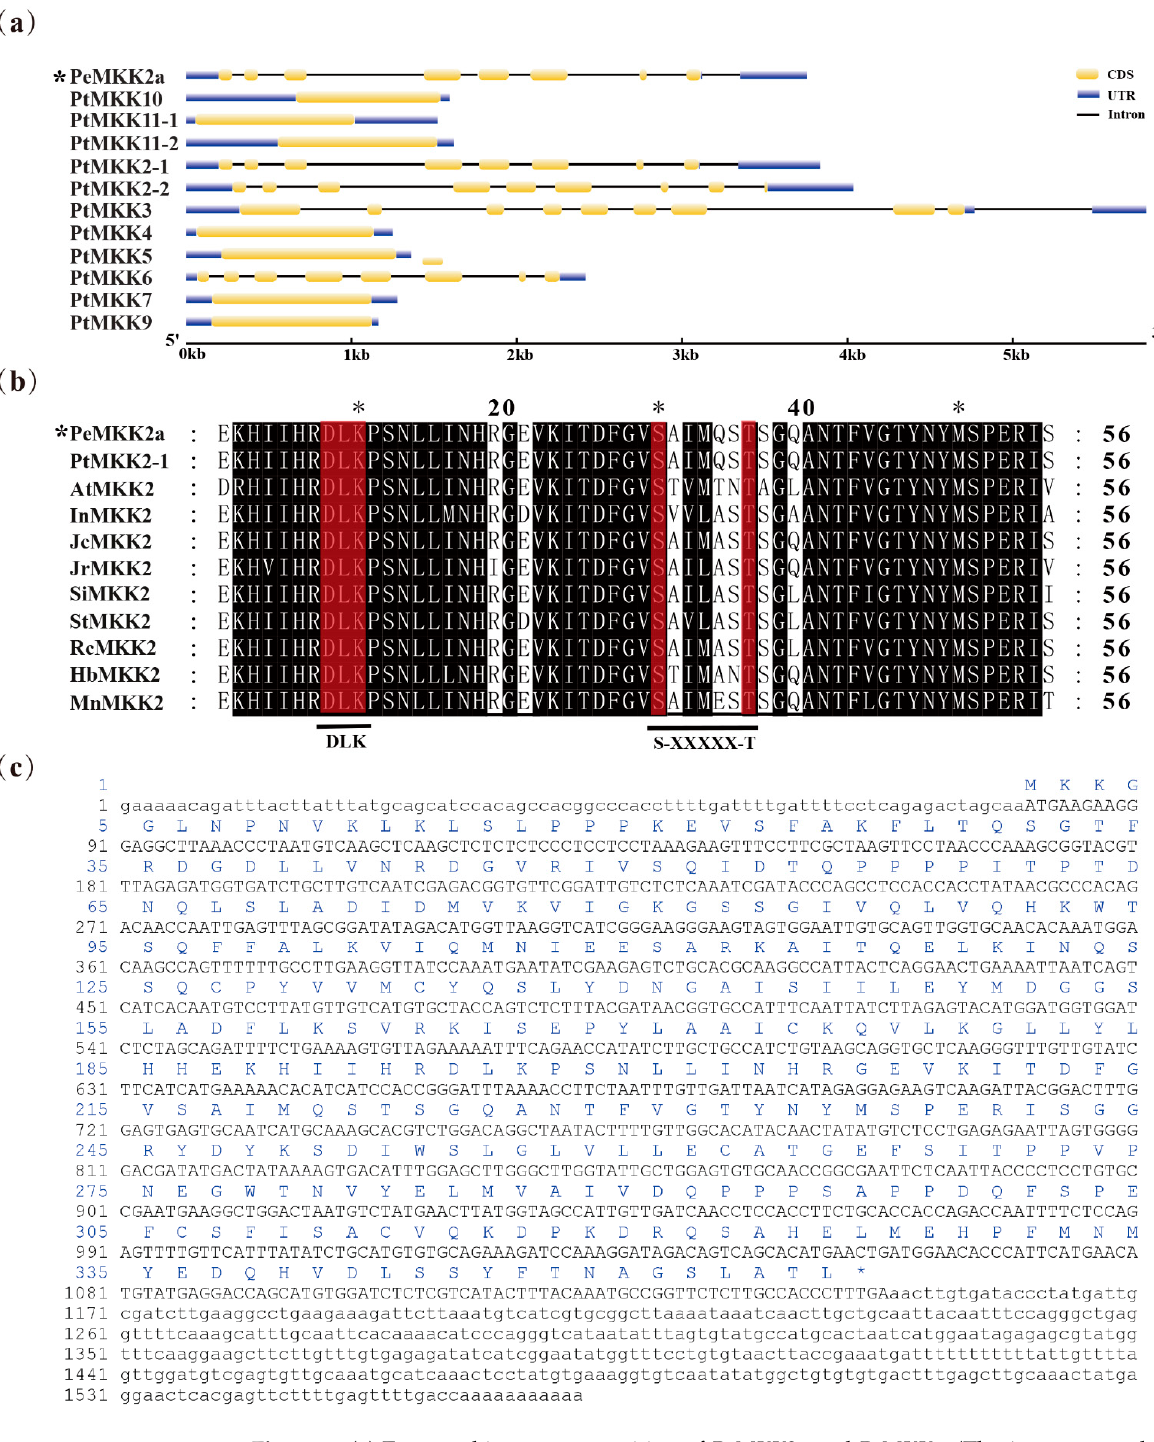
Figure 1. ( a ) Exon and intron composition of PeMKK2a and PtMKKs . (The * represents the MKK2 gene cloned from “Nanlin 895”). ( b ) Multiple alignment of amino acid sequences of MKK2 proteins in different plant species. The black background indicates conserved regions, and the red background indicates specific conserved structural domains. (Here, only part of the sequence is shown.) ( c ) Nucleotide and deduced amino acid sequences of PeMKK2a